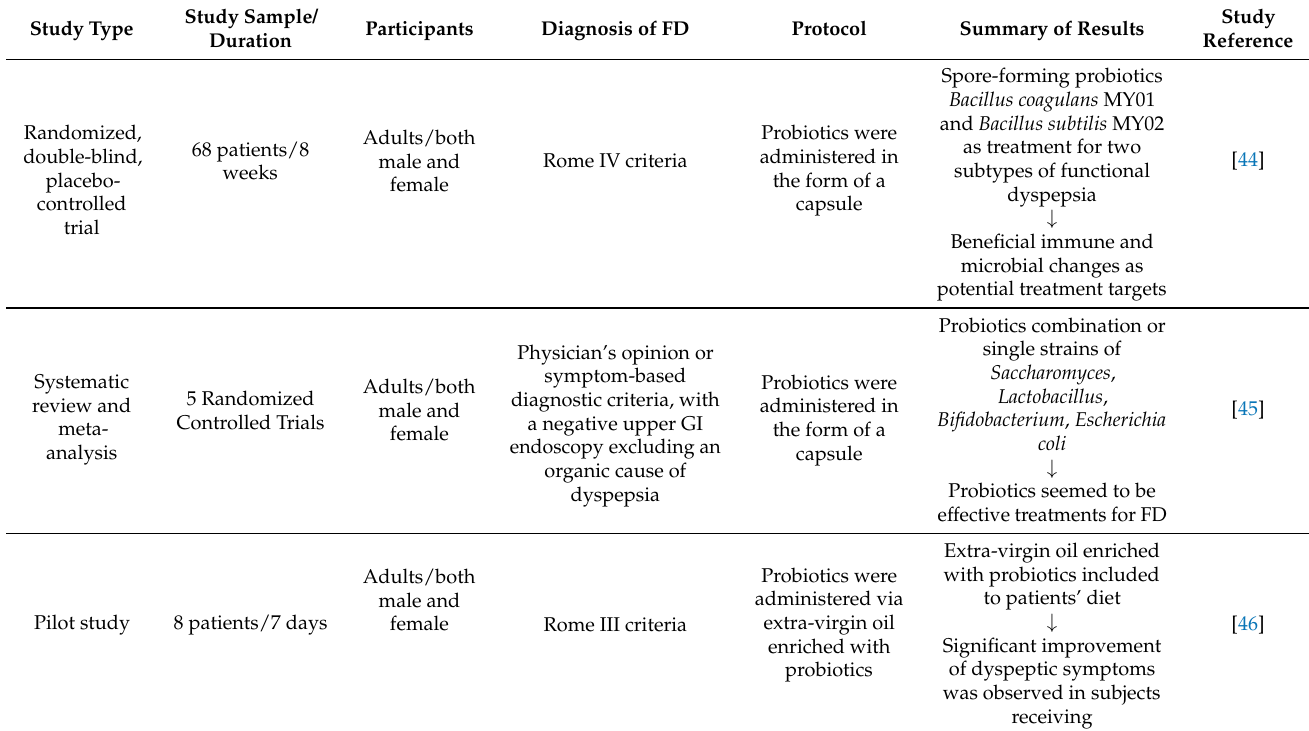
Table 2. Studies that summarize the efficacy of probiotics in treating functional